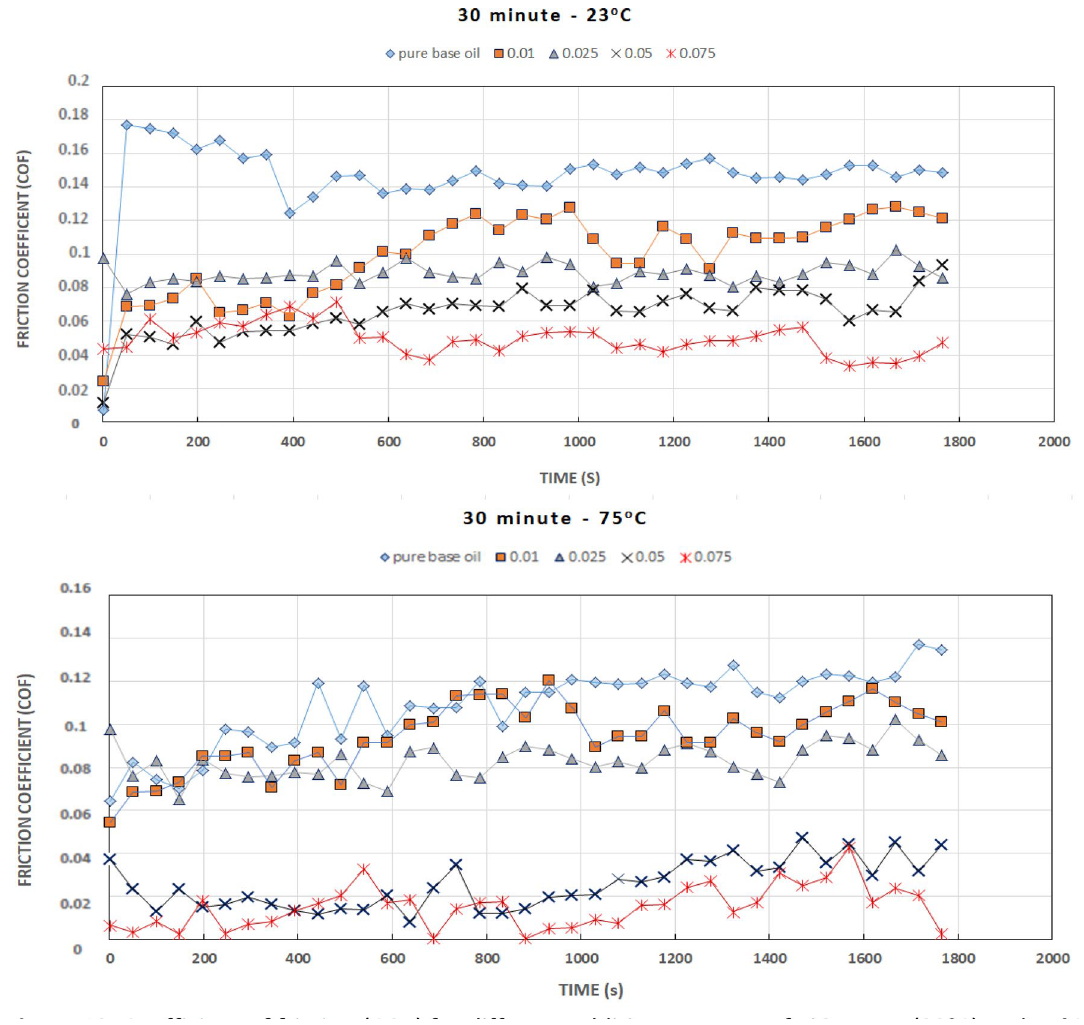
Figure 13. Coefficient of friction (COF) for different additive amounts of TiO 2 at RT (23 °C) and 75 °C.